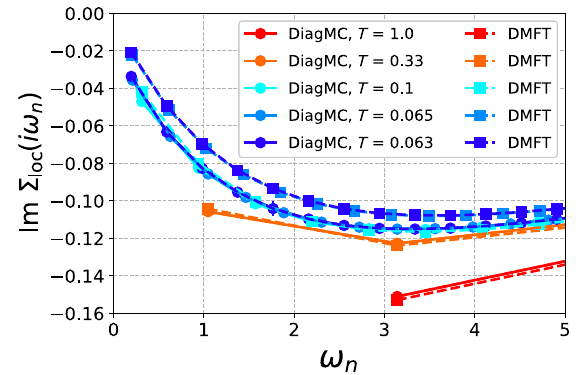
FIG. 5. Imaginary part of the local self-energy calculated by DiagMC compared to DMFT. Note that the two lowest temper- atures displayed, at which a discrepancy appears, correspond to the DMFT ordered phase.